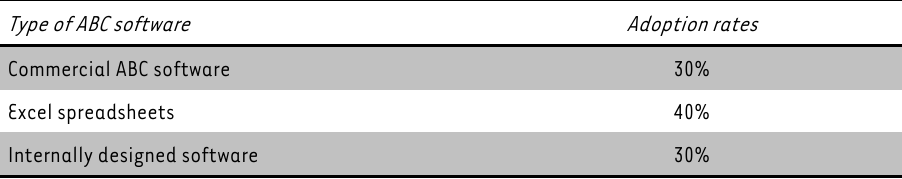
TABLE 2: Breakdown of the different types of ABC software used by health care facilities Type of ABC software